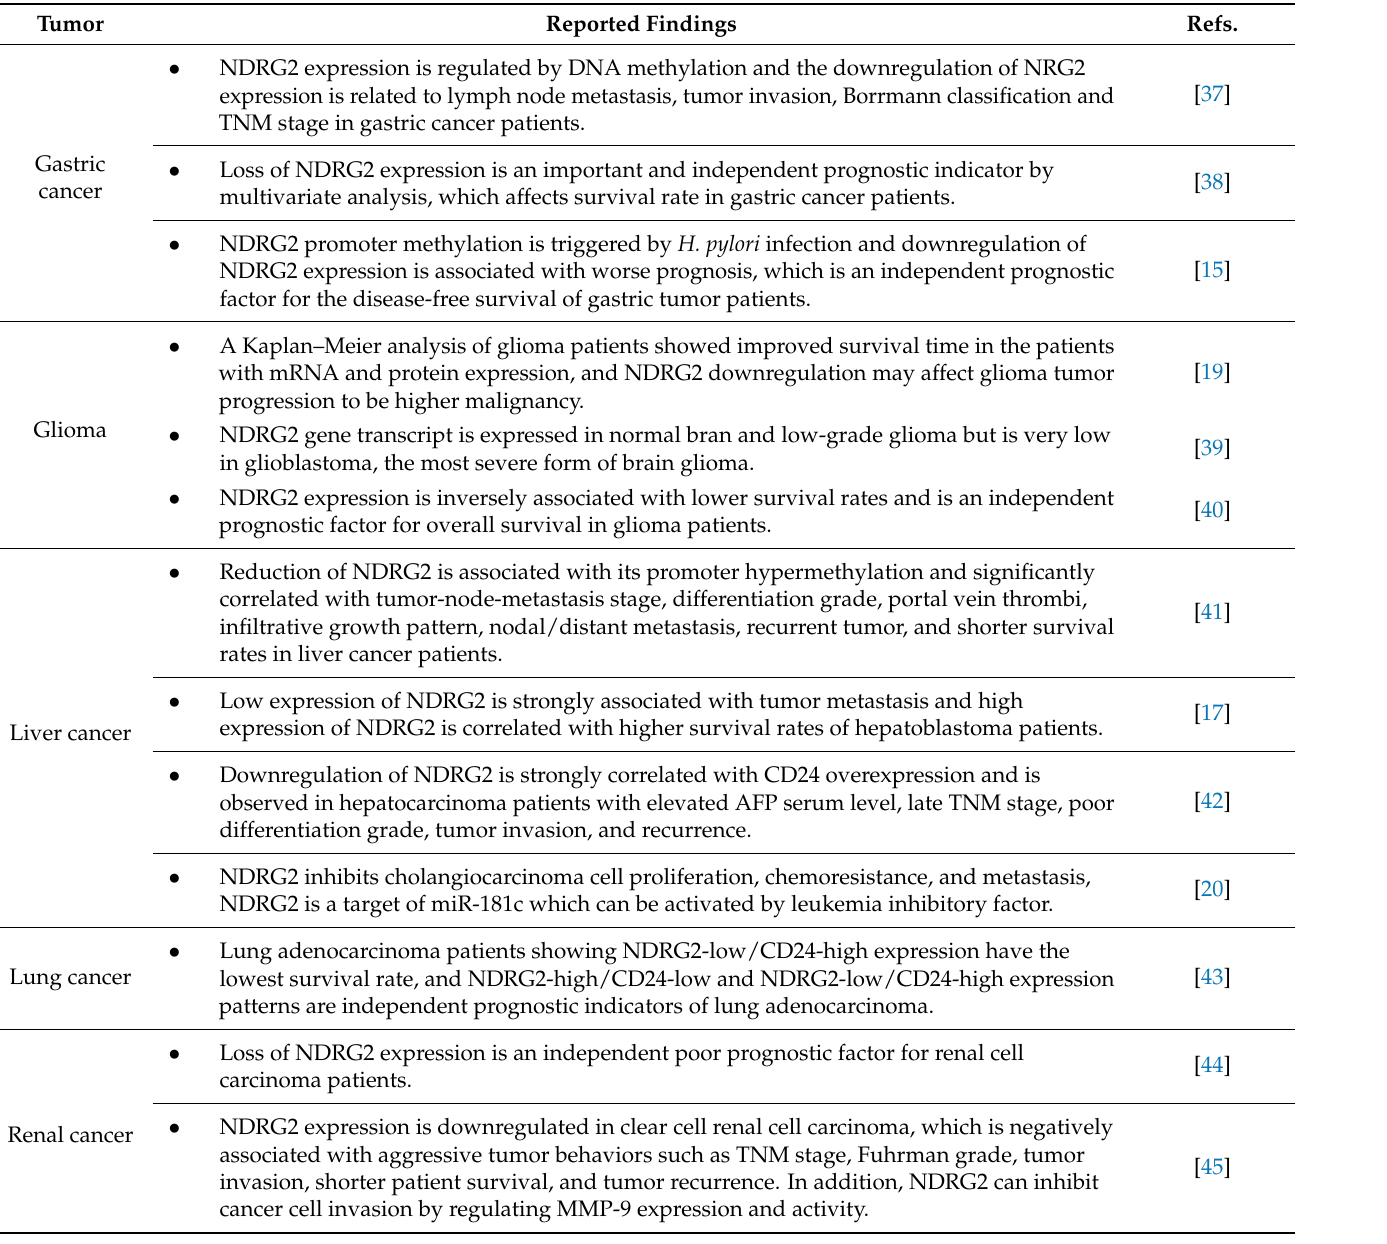
Table 1. Cont. Reported Findings